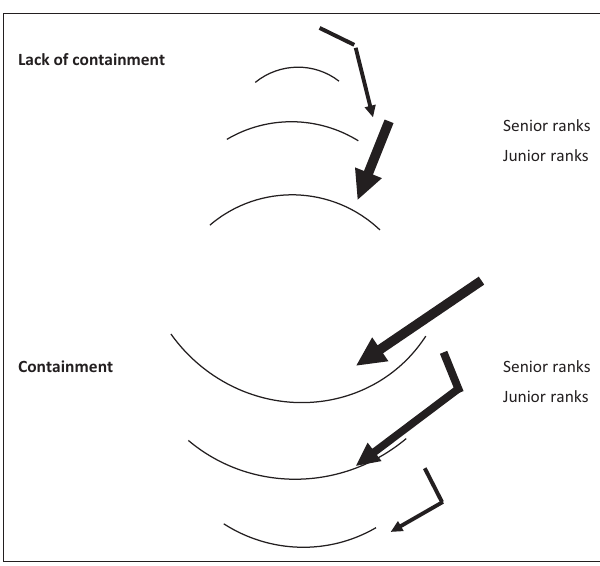
FIGURE 2: The interaction between senior and junior ranks in terms of providing containment: Absorbing stressors or deflecting stressors